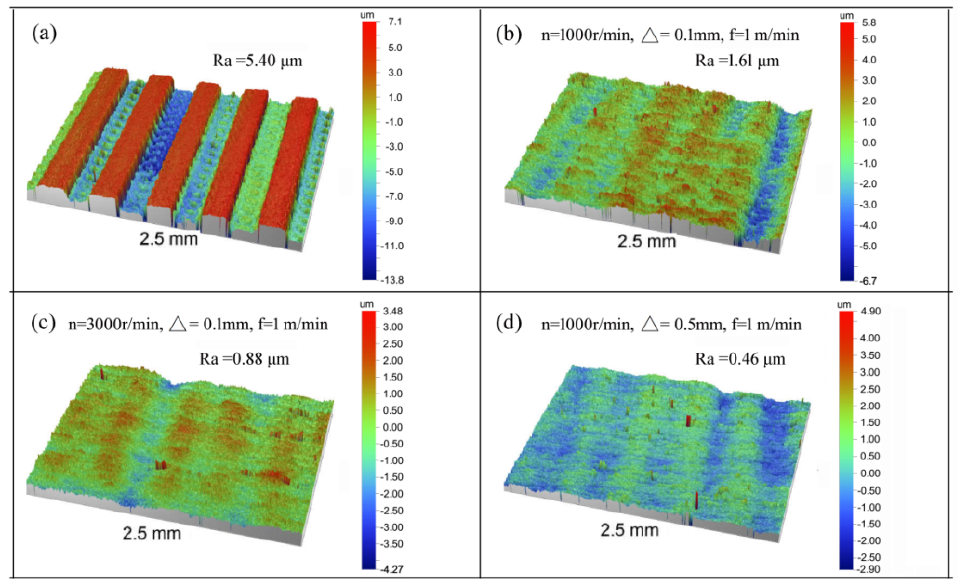
Figure 6. The experiment morphology ( a ) before brush grinding, and the experiment morphology ( b – d ) after brush grinding, at different process parameters. ( b – d ) after brush grinding, at different process